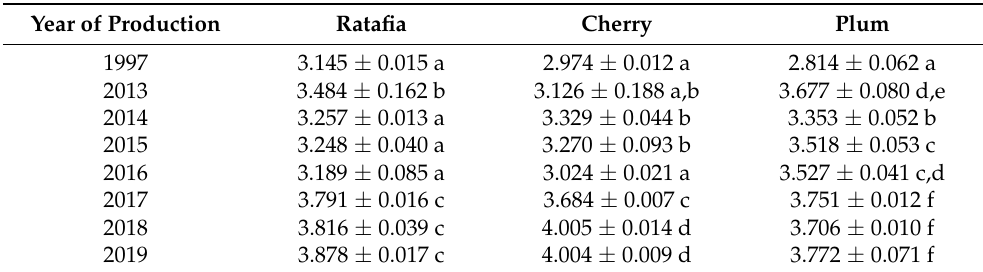
Table 1. The antioxidant activity of nalewkas was measured by the DPPH method (mean ± SD, n = 3). Different letters indicate significant differences between the individual years. The result was expressed in mg Trolox · g − 1 of nalewka.